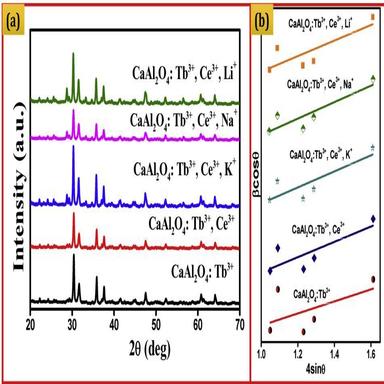
(a & b) PXRD patterns and W-H plots of optimized NPs.